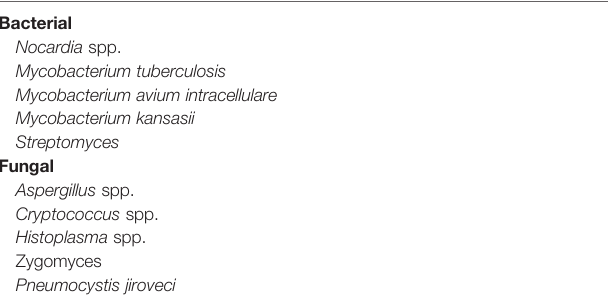
TABLE 3 | Opportunistic pathogens commonly seen in patients with autoimmune pulmonary alveolar proteinosis. Bacterial Nocardia